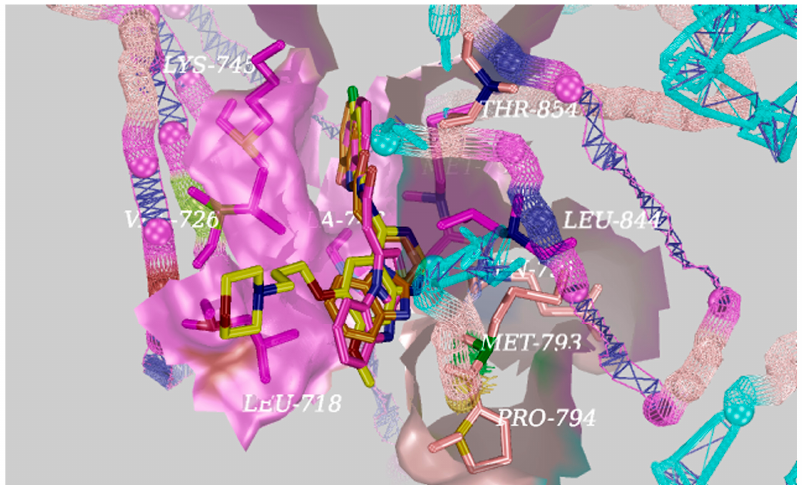
Figure 5. The interactions of EGFR with D04 (orange), D08 (purple), and gefitinib (yellow) shown by PyMOL.